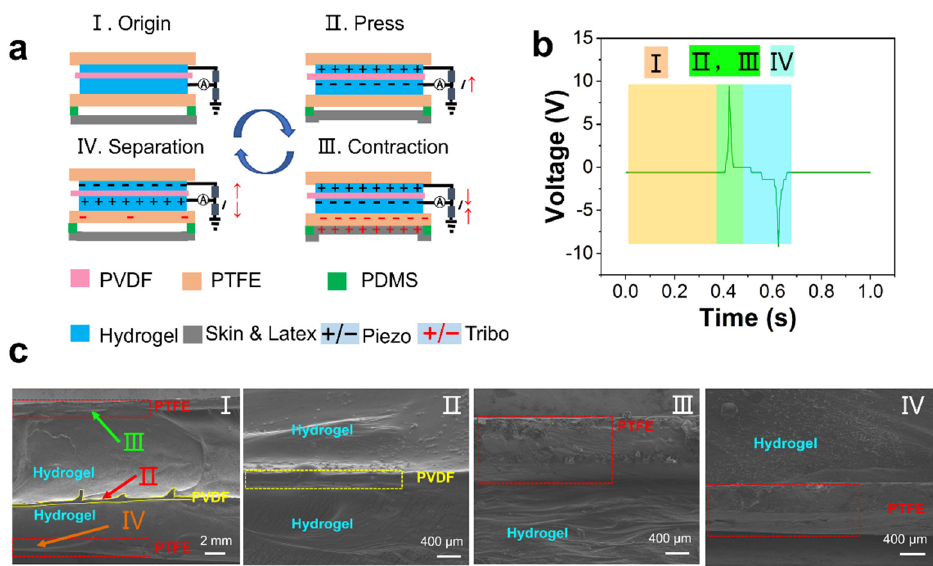
Figure 2. The mechanism of PTSS and SEM of PENG. ( a ) Coupling mechanism of TENG and PENG. ( b ) Corresponding signal. ( c ) The SEM image of PENG.